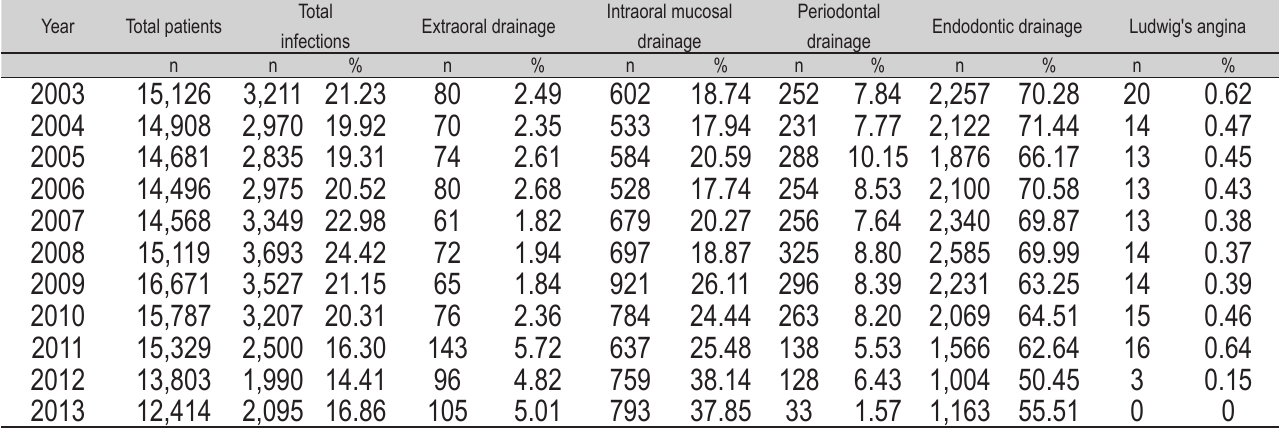
Table 1 - Total number of patients from 2003 to 2013 in HMOB’s Dental Department and the frequency of infections and procedures. Year Total patients